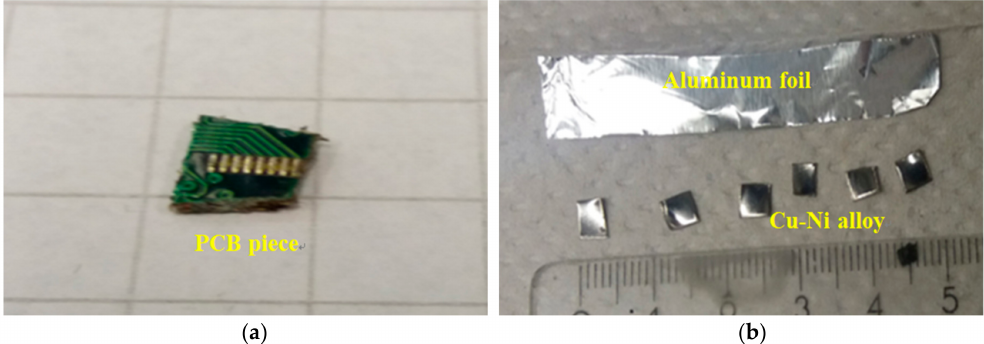
Figure 1. Materials utilized in this study: ( a ) printed circuit-board (PCB) piece; ( b ) synthetic PCB